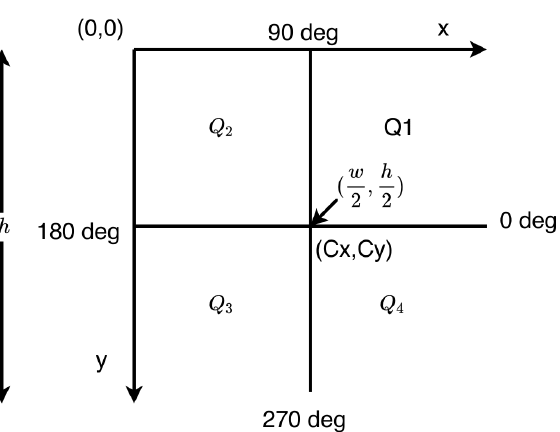
Figure 5. Image segmentation into four distinct quadrants for target localization.